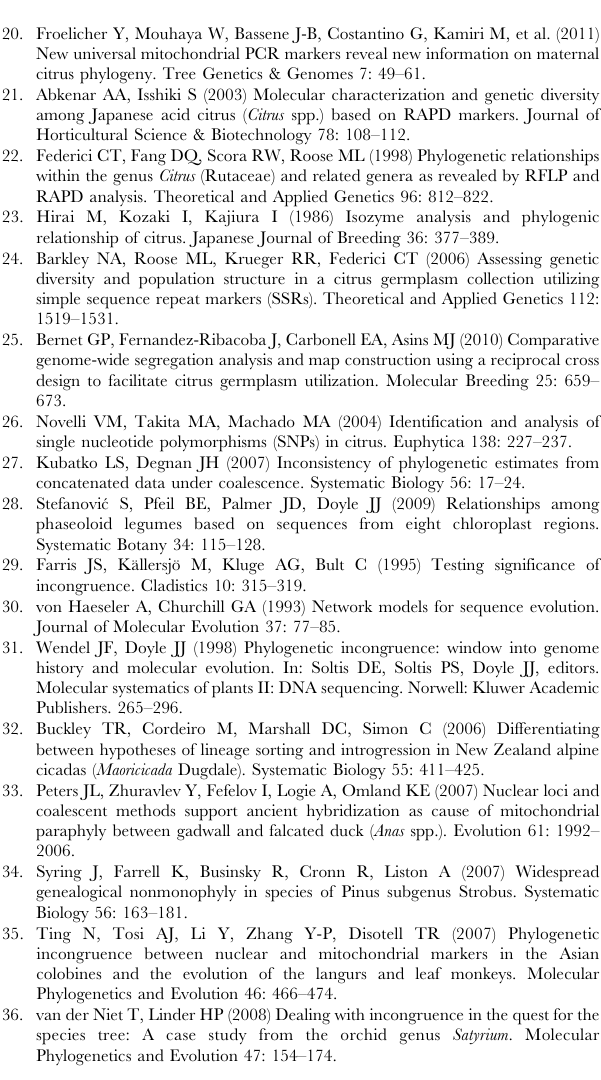
Table S6 Inferred ancestry of individuals included in Structure and SNP analysis. Numbers in columns